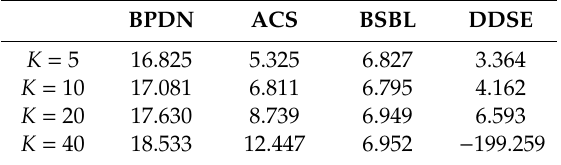
Table 4. Average running time of di ff erent algorithms